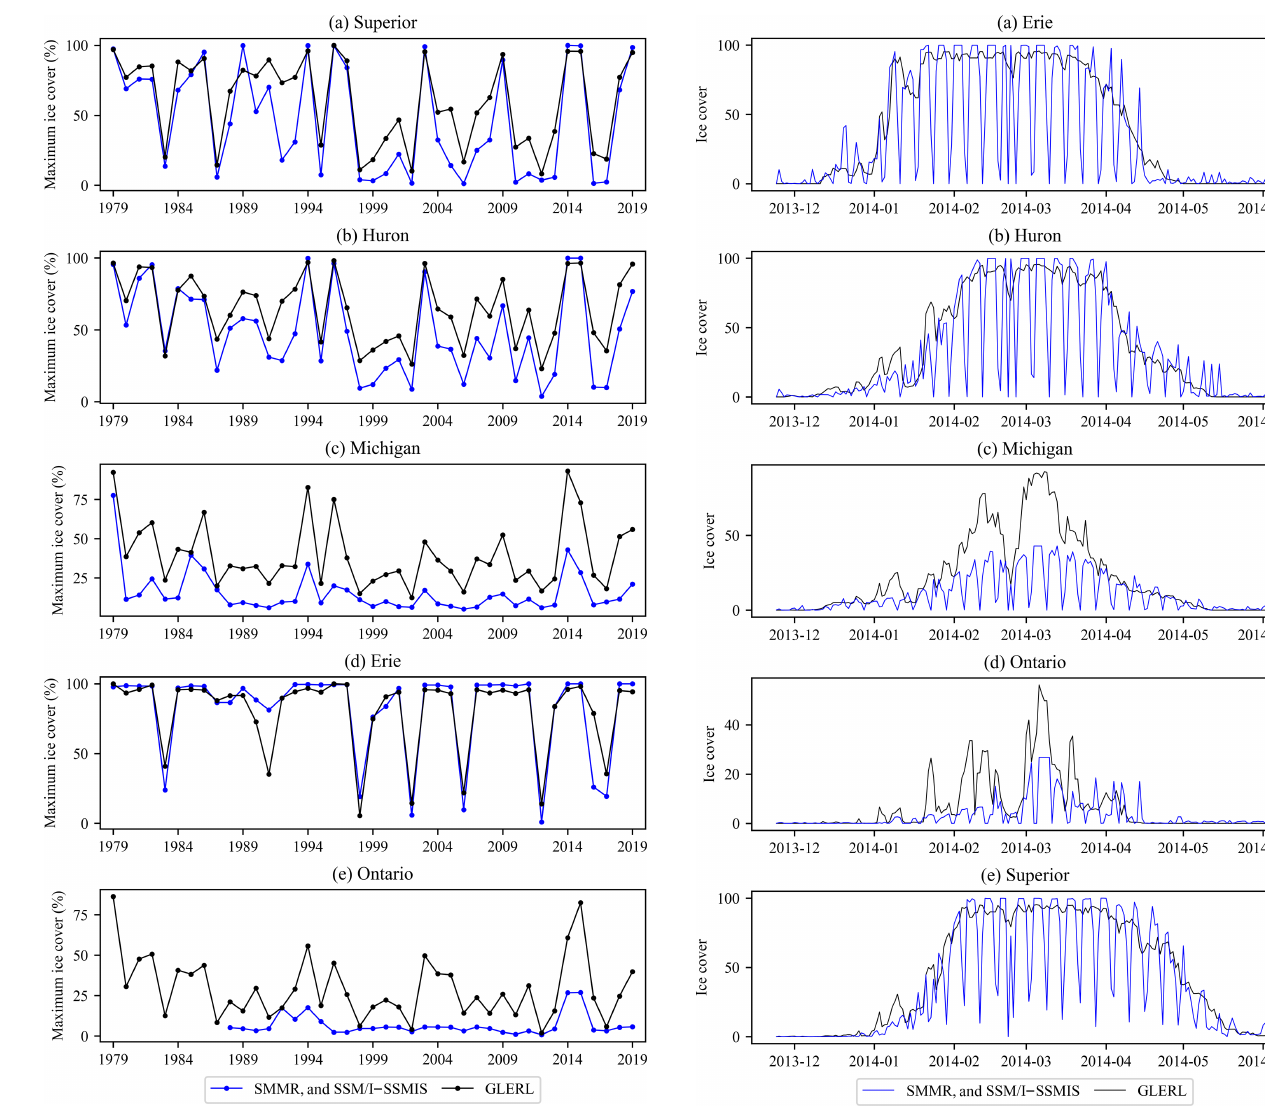
Figure 8. Comparisons of the daily ice cover (percentage of lake area) of the Great Lakes from the GLERL records and SMMR and SSM/I–SSMIS data in 2014: (a) Superior, (b) Huron, (c) Michigan, (d) Erie, and (e)